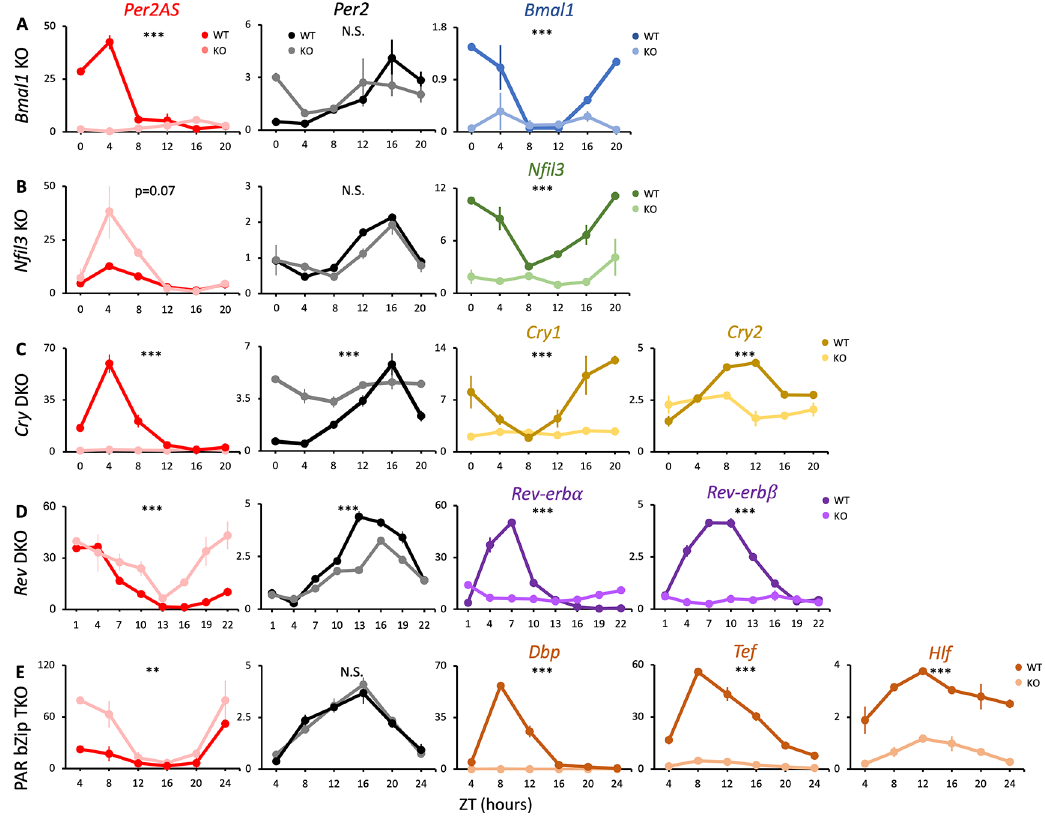
Figure 1. The expression patterns of Per2AS and Per2 in the knockout mice of core clock genes. Mice were kept under an L:D=12:12 cycle and fed ad libitum. Liver RNAs were extracted every four hours in (A) Bmal1 , (B) Nfil3 , (C) Cry1/2 double, and (E) Dbp/Tef/Hlf triple knockout mice (n=2), or every three hours in (D) Nr1d1/2 double knockout mice (n=3). Y-axis represents strand-specific TPM. Points and error bars represent mean (cid:2) SE. (**) p<0.01, (***), p<0.001, N.S. indicates no significant difference between genotypes (two-way ANOVA). Data derived from Weger et al ., Proc Natl Acad Sci U S A , 2020 34 ; Yoshitane et al ., Commun Biol. , 2019 38 ; Guan et al ., Science , 2020.